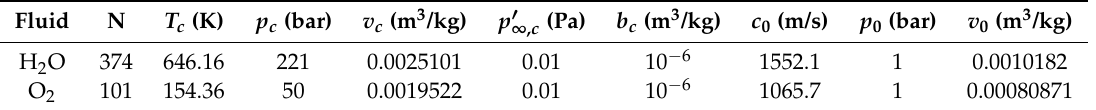
Table A1. Reference state values used for the determination of liquid Extended Noble–Abel Stiffened-Gas (ENASG) coefficients.